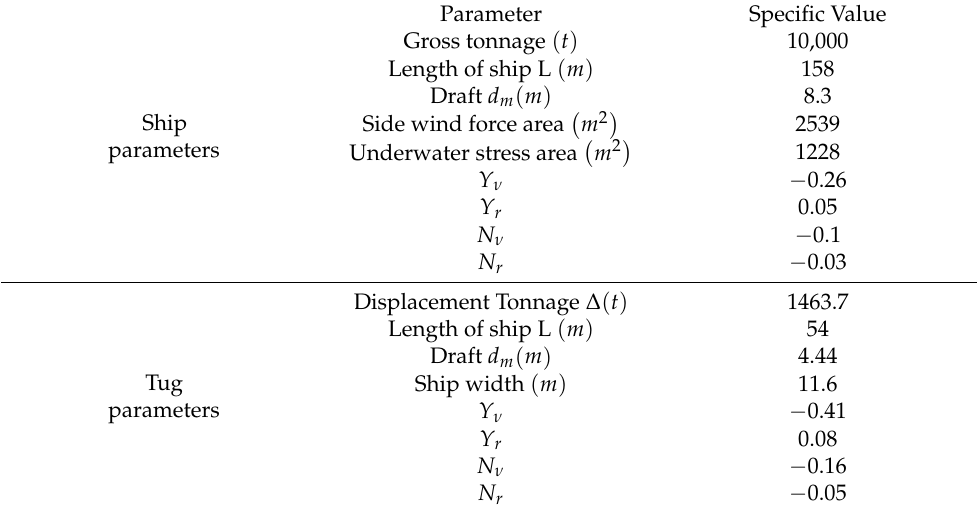
Table 1. Theparametersof ship and